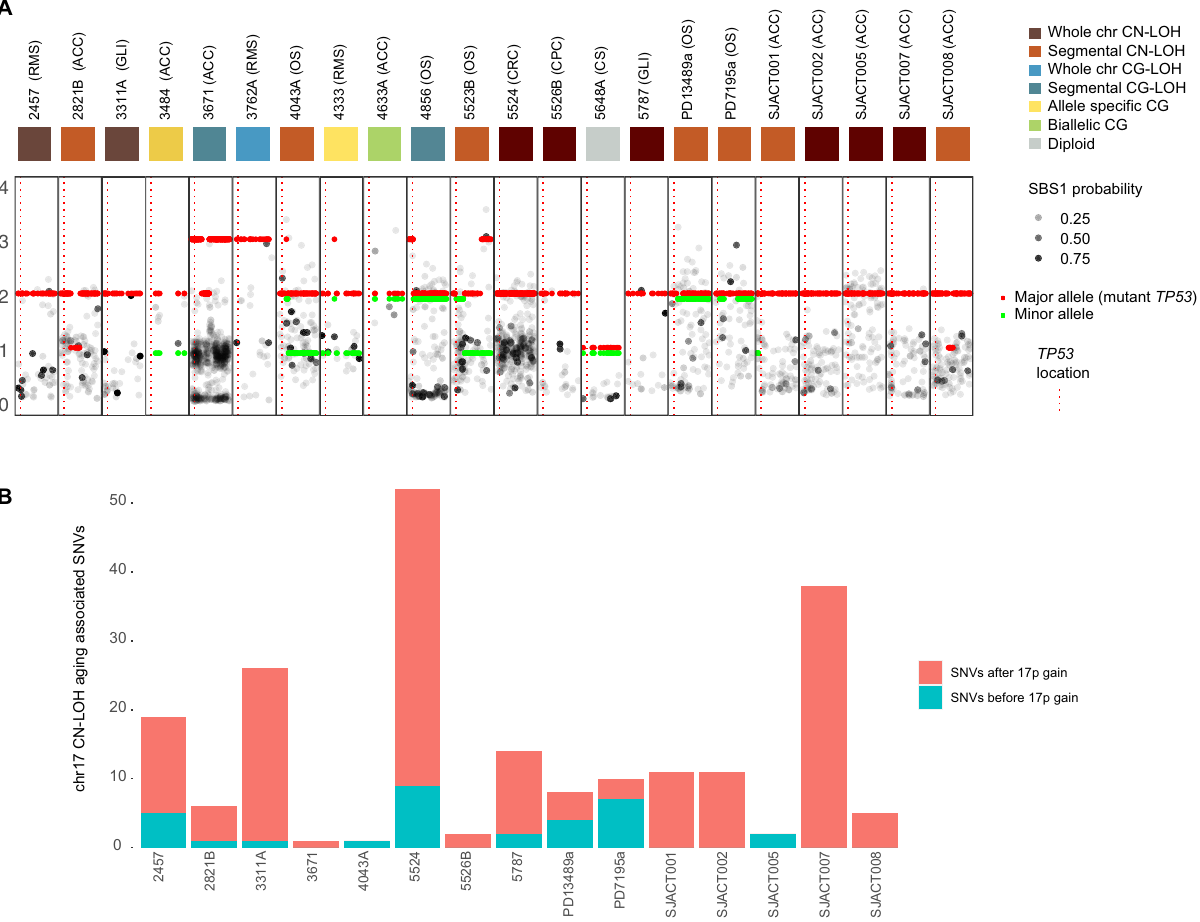
Fig.3| TP53 LOHisanearlyeventinthelifetimeofLFSpatients.A Copynumber of somaticindividualmutations (blackand graypoints) onchromosome 17 across cohort of TP53 -germline mutant tumors. Each black box represents chromosome 17 for one tumor. X-axis for each black box is the position on chromosome 17; Y - axis shows the copy number. Red and green bars are major and minor copy number. Gray points are colored by probability of contributing to SBS1 (clock-like